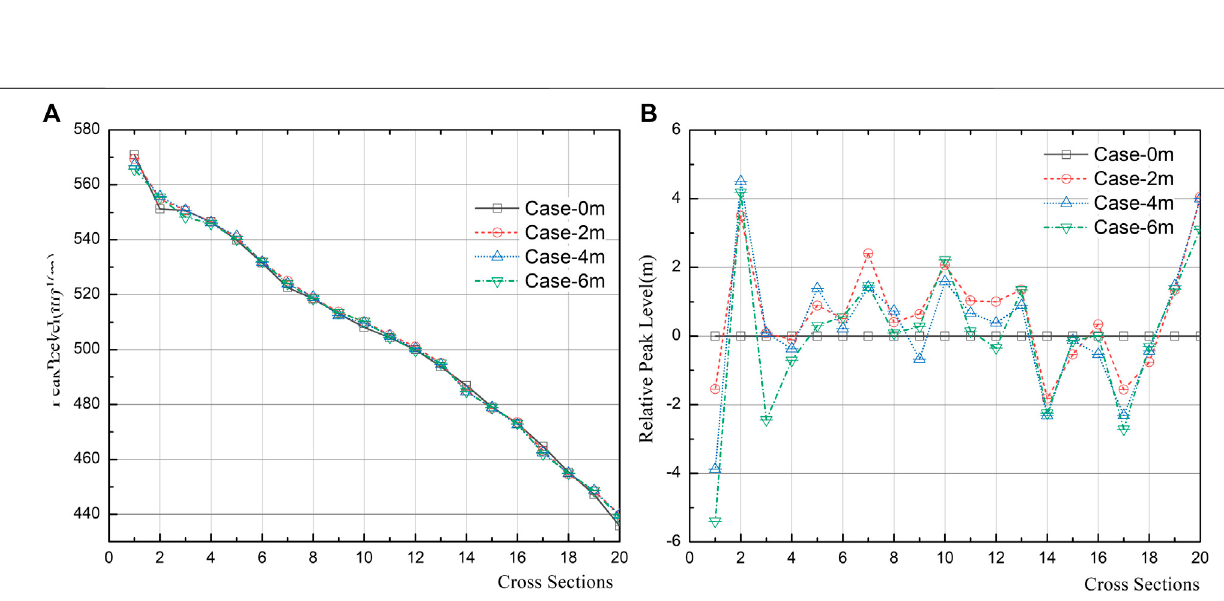
FIGURE 7 | Peak water level (A) and relative peak water level (B) at cross